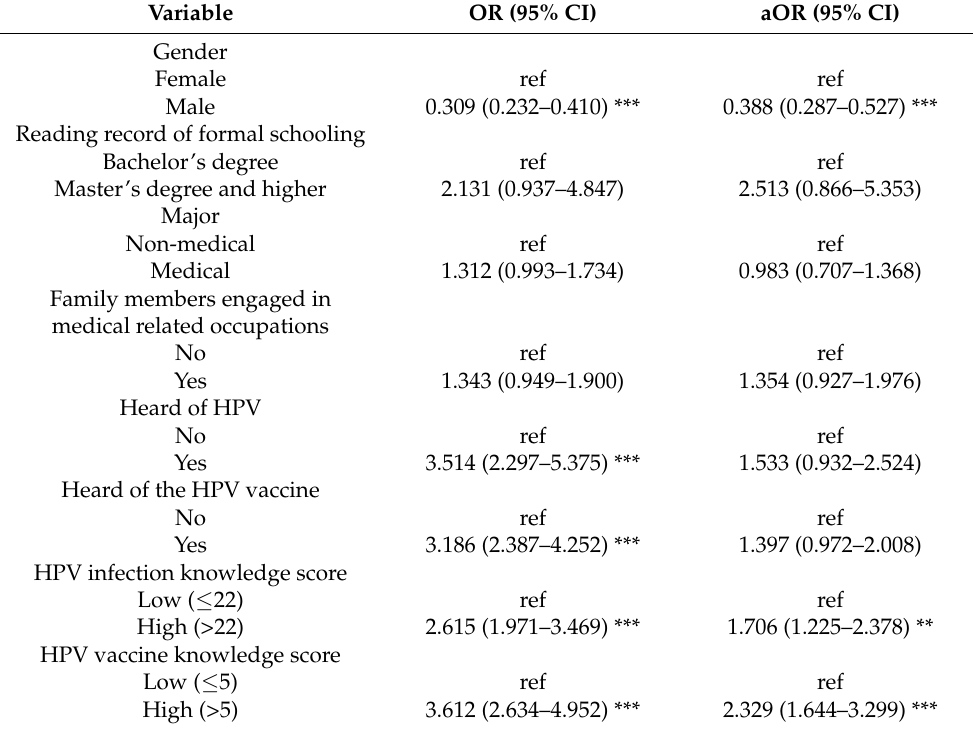
Figure 2. Self-reported facilitators of and barriers to HPV vaccination acceptance. Note: Only participants willing to be vaccinated with HPV answered the question “What are the reasons why you are willing to get HPV vaccination? (multiple choice)” ( n = 714); only participants who were unwilling to vaccinate with HPV answered the question “What are the reasons that influence you to get HPV vaccination? (multiple choice)” ( n = 288). Table 3. Factors associated with the willingness to receive HPV